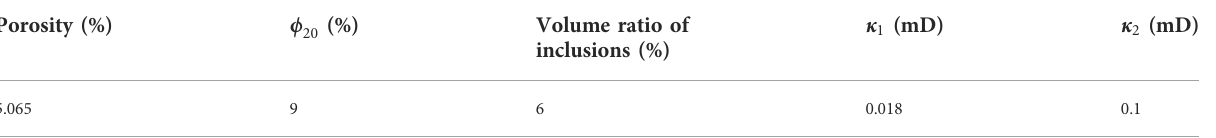
TABLE 2 Modeling parameters of sample 1 –